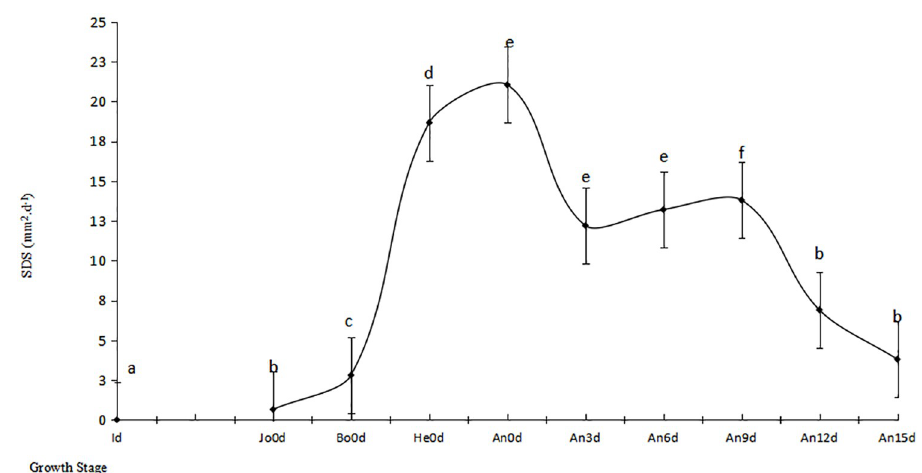
Fig 3. Dynamic of disease speckles speed. Note: Id was the first time of inoculation.